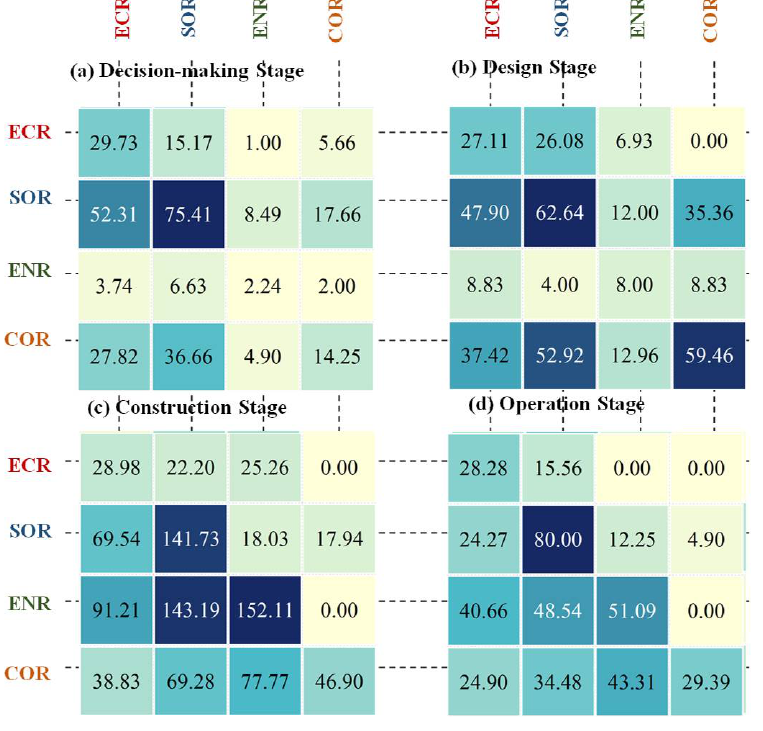
Figure 7. Direct inter-group